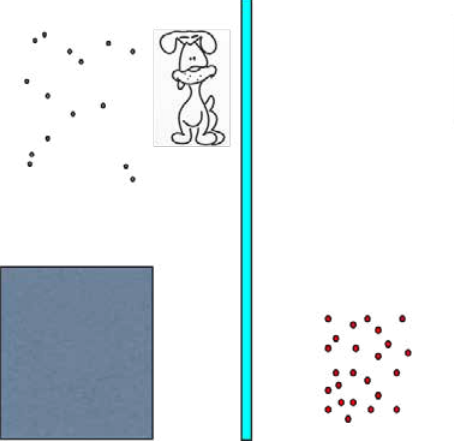
Figure 1: Example problem for approximate